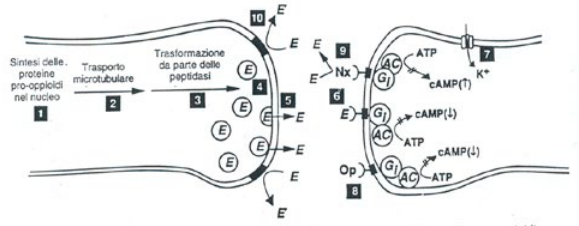
Figure 15. General scheme of peptidergic synapses. 43